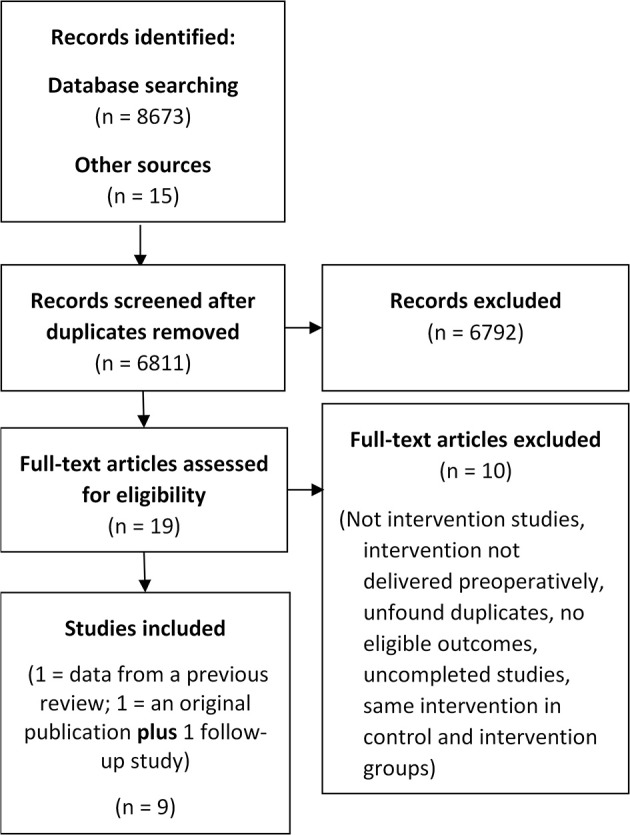
Flow diagram of the screening process.